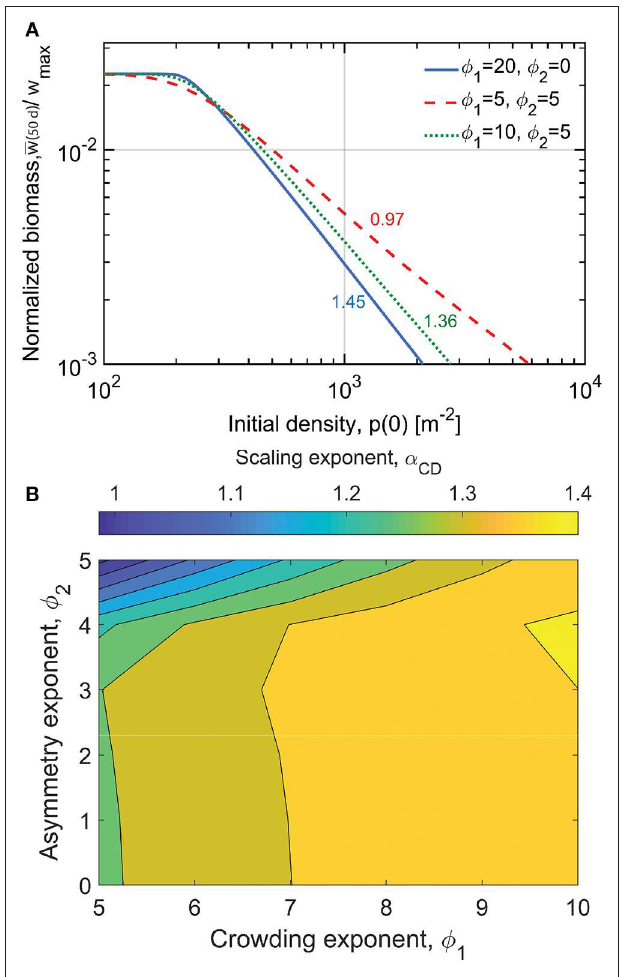
FIGURE 5 | Modeled temporal variations of biomass per unit ground area with time for three competition types with less and more prominent size asymmetry effect (respectively smaller and larger φ 2 ). (A) At low φ 2 , model runs with different initial densities p 0 (m − 2 ) result in divergent final yields. Mortality only occurs in the low density plots as indicated by the circles. The final densities [ p (150) in m − 2 ] as indicated by the color-coded numbers on their corresponding curves are not very different from p 0 . (B) At medium size asymmetry, final yields are closer than in (A) , but differences still occur after 150 days. Mortality is present in all four plots. (C) At high size asymmetry, final yields are the same regardless of p 0 90 days into the simulation which corresponds to the constant final yield rule. All plots reach the same low final density of 15 m − 2 . Model parameters are found in Table S3 . Circles designate the onset of mortality in time and color-coded numbers are the final densities at the end of the 150 days corresponding to each